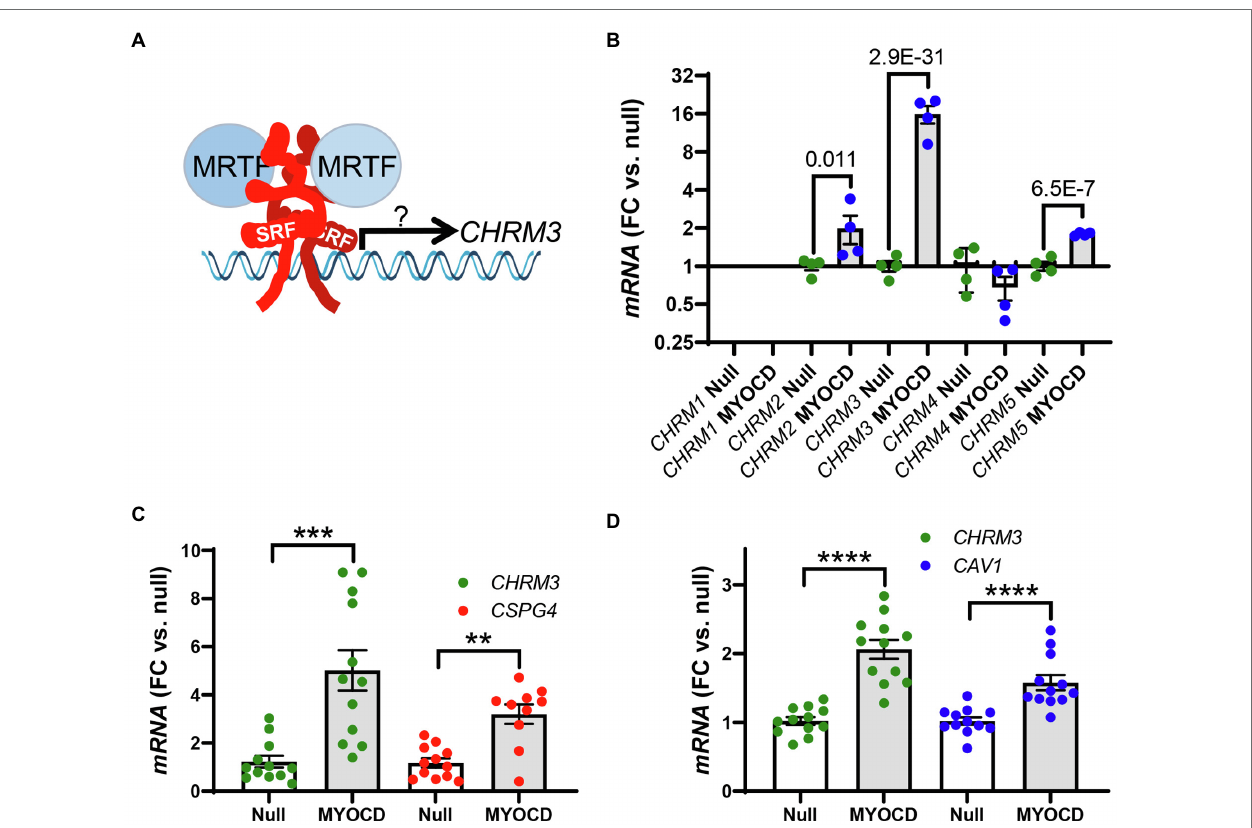
FIGURE 1 | The transcriptional coactivator myocardin (MYOCD) regulates expression of the M 3 muscarinic receptor ( CHRM3 ). Panel A shows a schematic representation of the hypothesis that we set out to test in the present work, namely, that myocardin-related transcription factors (MRTFs) control expression of the M 3 muscarinic receptor for acetylcholine ( CHRM3 ). Panel B shows data from an RNA-sequencing experiment were MYOCD was overexpressed in cultured human coronary artery smooth muscle cells (hCASMCs) for 8 days (n = 4 null and 4 MYOCD). Ad-CMV-MYOCD was used for overexpression, and Ad-CMV-null virus at the same multiplicity of infection was used as control. The full dataset of differentially expressed genes is given in the Supplementary Material . Brackets in panel B show adjusted P-values for the indicated comparisons of M 2 ( CHRM2 ), M 3 ( CHRM3 ), and M 5 ( CHRM5 ) receptor transcripts between conditions. Panels C and D show confirmation using RT-qPCR ( n = 12 throughout) that overexpression of myocardin (96 h) upregulates the M 3 receptor transcript. Experiments were run using human coronary artery SMCs in C and using human bladder SMCs in D . CSPG4 and CAV1 were used as positive control targets in C , D . Bar graphs in this and the following figures show means ± SEM, but individual data points are also given. ****p<0.0001, ***p<0.001 and